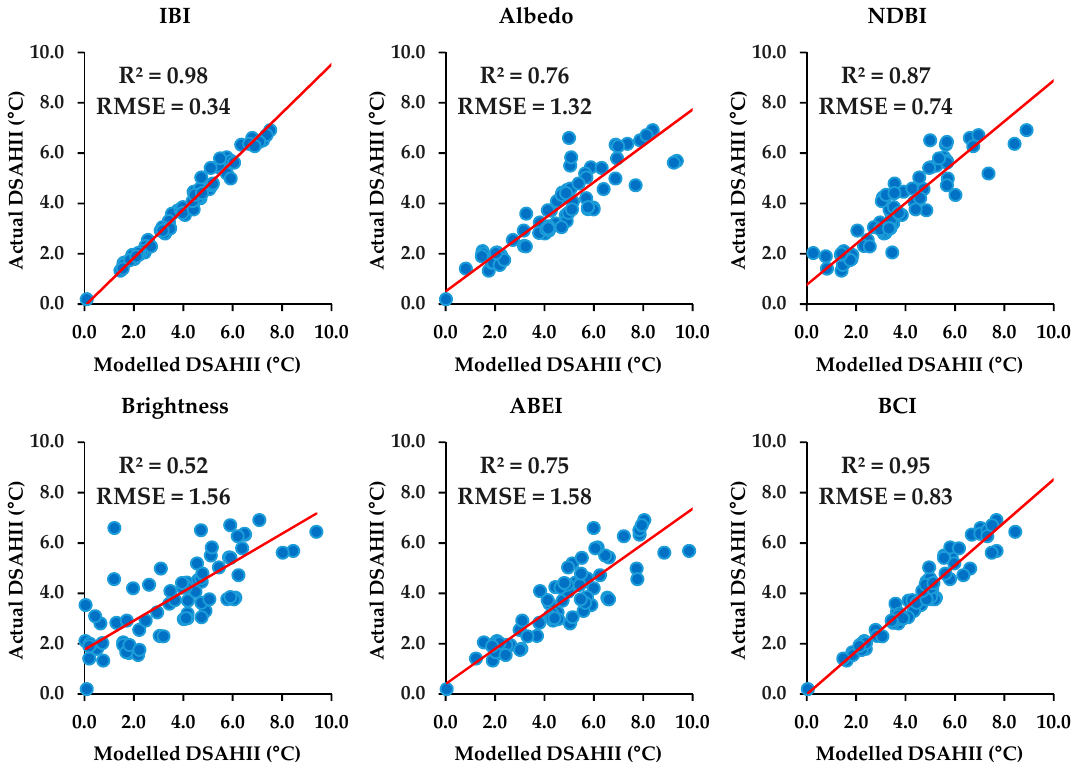
Figure 7. The obtained R 2 and root mean square error (RMSE) values between the actual and modelled